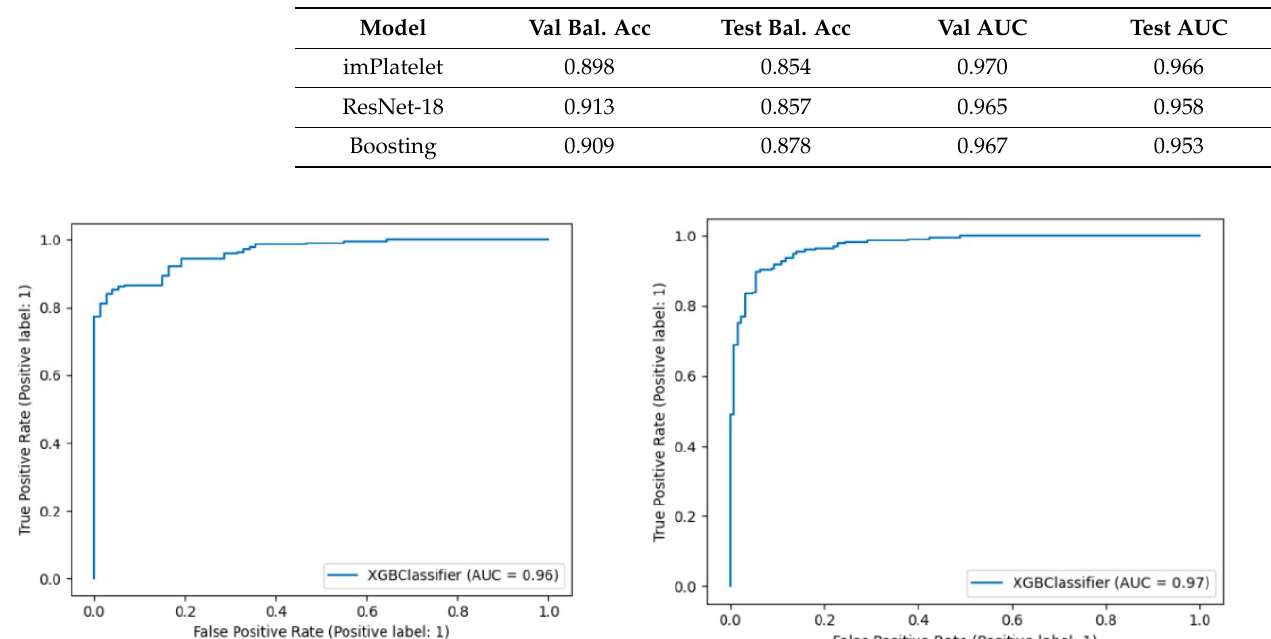
Figure 2. Area under the curve for the first experiment (left image) and on the transfer to the new hospital (right image). Table 5. Results of the experiment transfer to a new hospital.